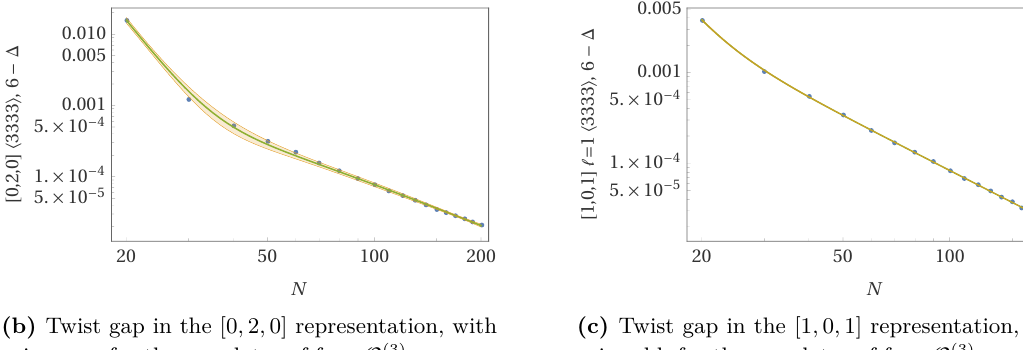
spin odd, for the correlator of four O (3) . Figure 8. Numerical fit in logarithmic scale following (6.1) of the smallest twist gap allowed in the respective channels. The numerical values of the curves in green is shown in equation (6.2a), (6.2b) and (6.2c) respectively. The yellow band is the error bar at 99% confidence